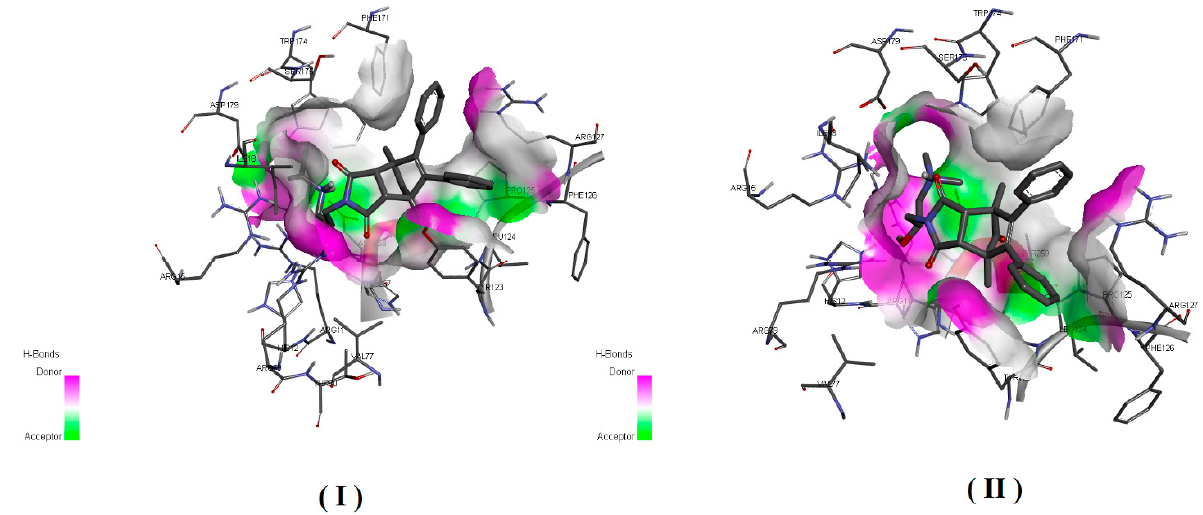
Figure 7. Structure and bioactive conformation of the inhibitor in a binding pocket of prostatic acid phosphatase.